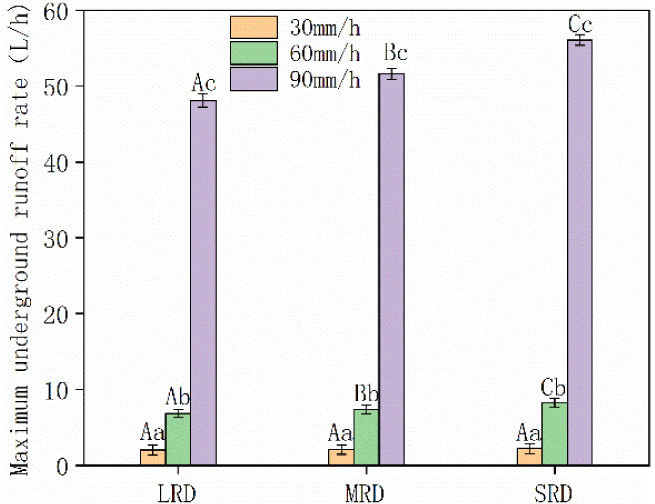
Figure 4. Maximun underground runo ff rate under di ff erent rainfall